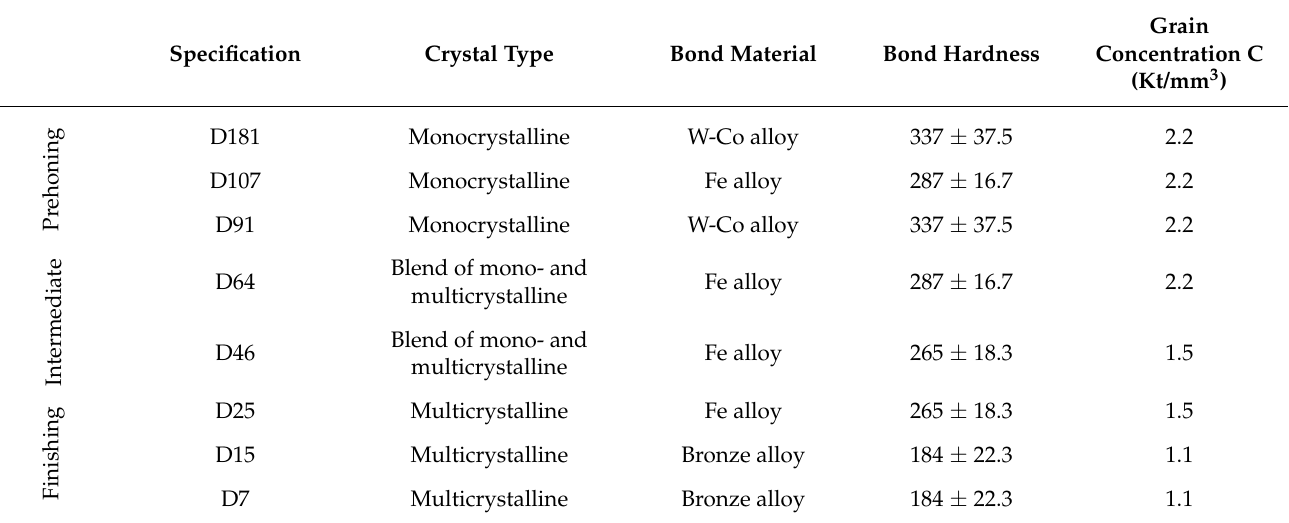
Table 2. Honing stone specifications used in